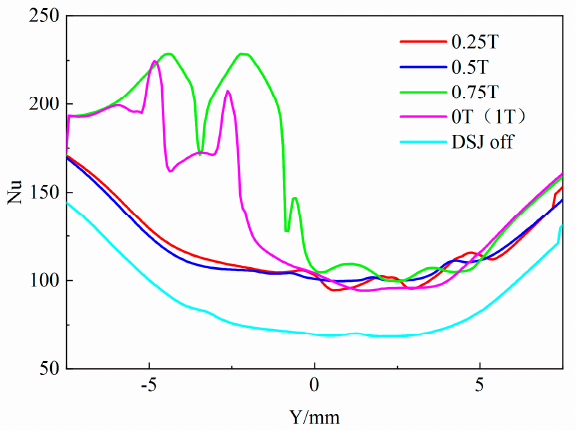
Figure 9. The distribution of Nu on the impact surface ( z = 44 mm) along the y direction.